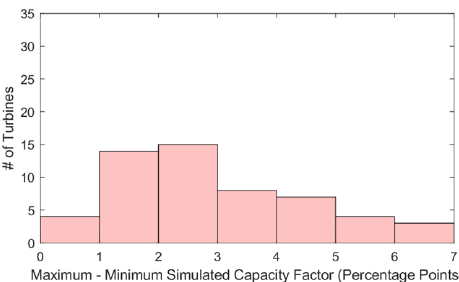
Figure 8. Maximum minus minimum SAM simulated capacity factor based on wind resource data from seven individual WIND Toolkit years across 55 small wind